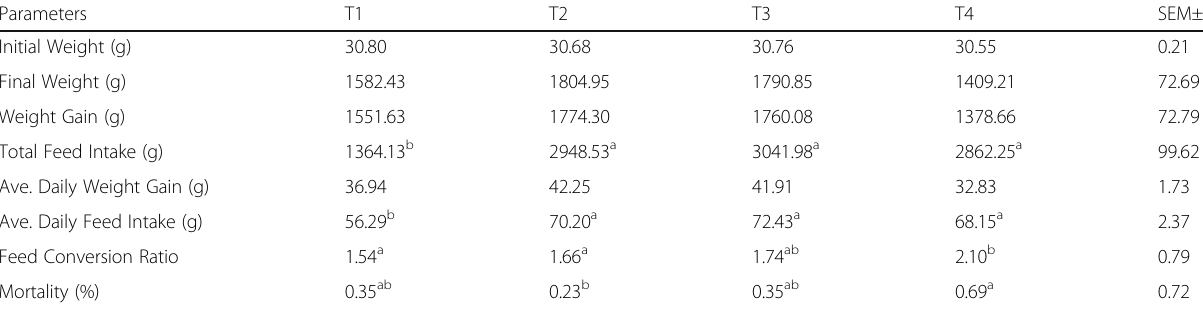
Table 3 Performance traits of broiler fed fungi treated cocoa pod husk meal Parameters